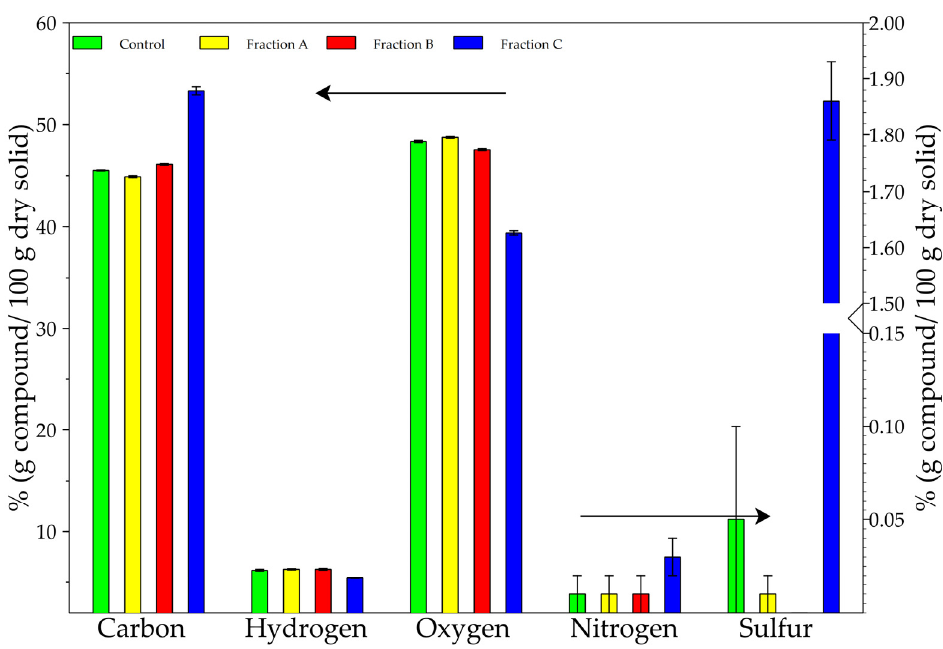
Figure 2. Comparative histogram bar chart of elementary analysis between control and fractions.